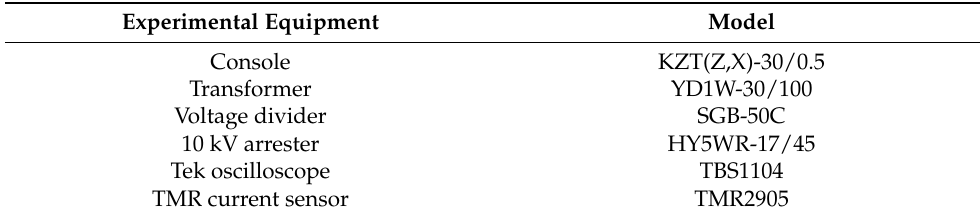
Table 4. Model of the experimental equipment.